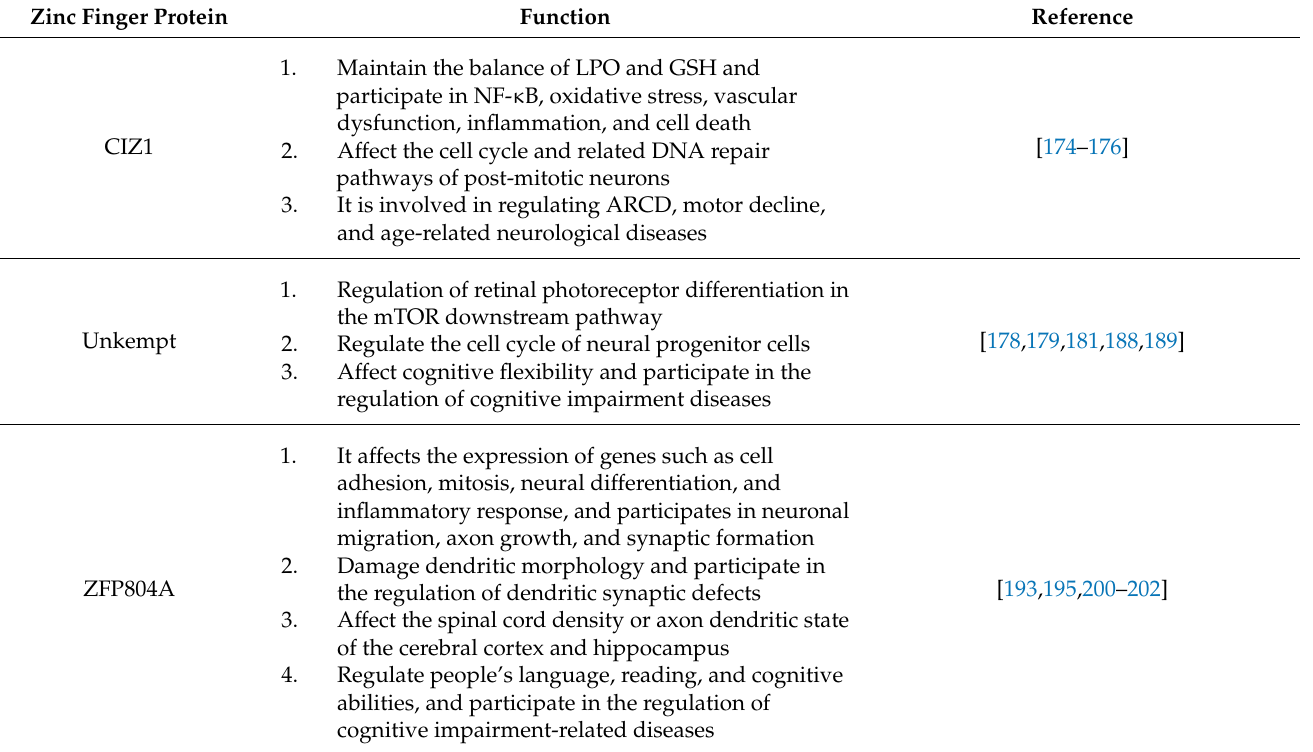
Table 2. Cellular pathways involved in ZFP regulation in the nervous system. Zinc Finger